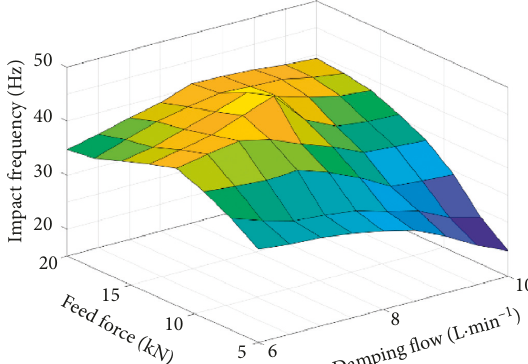
Figure 9: The comparisons of impact frequency under different combinations ( Q d , F d ).